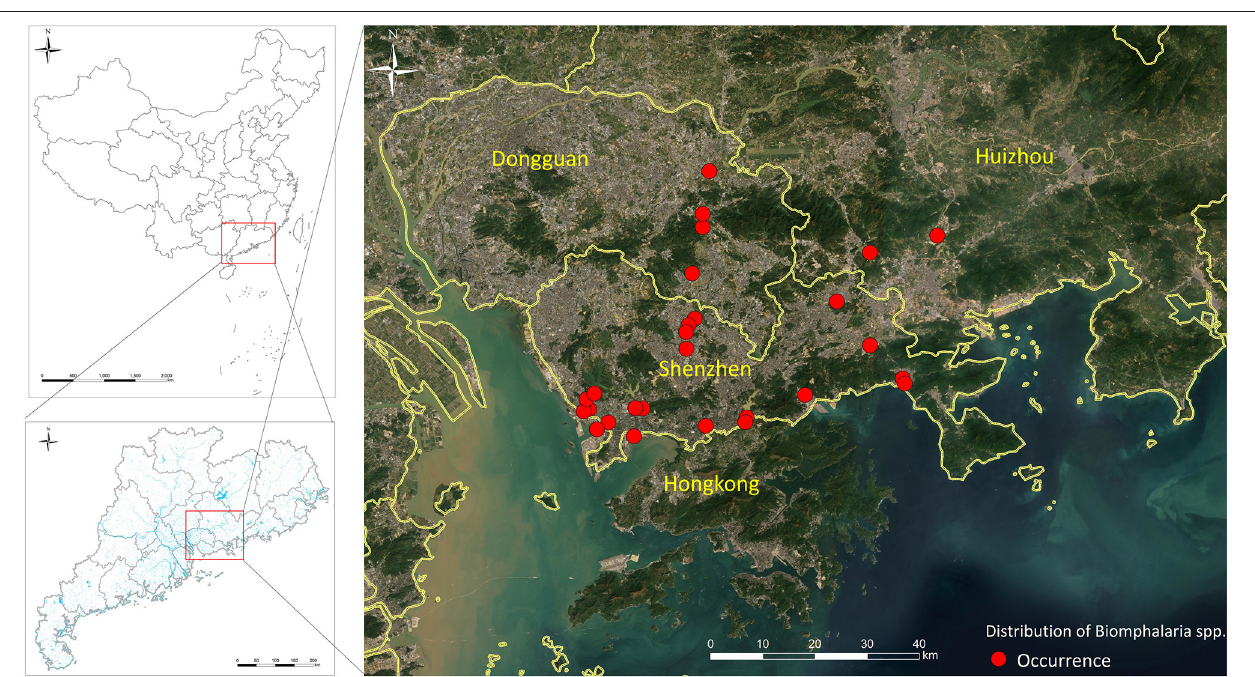
FIGURE 3 | Biomphalaria straminea distribution in the south part of